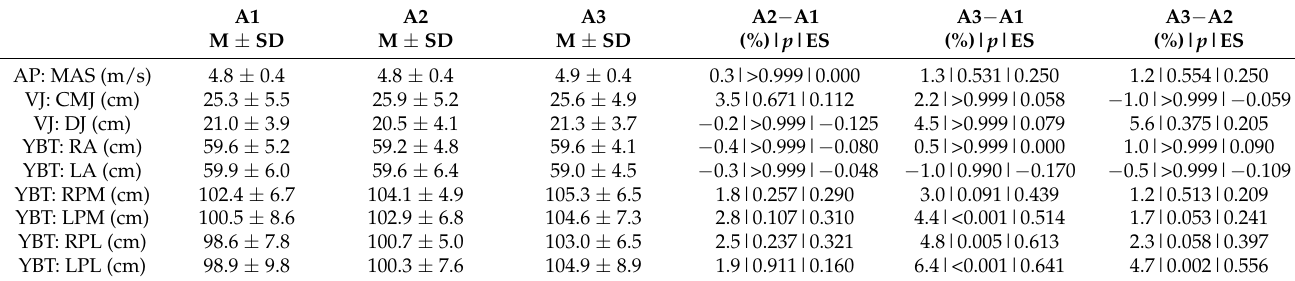
Table 1. Descriptive statistics of fitness variables assessed in the three periods of the season.